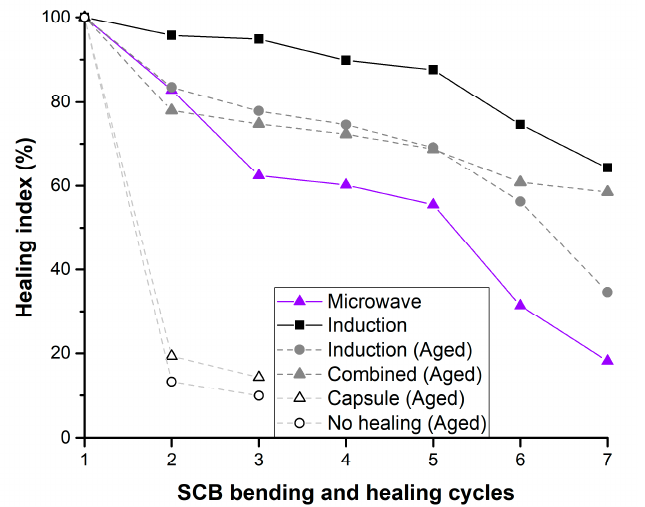
Figure 8. The healing efficiency of microwave healing systems in comparison with other healing systems.